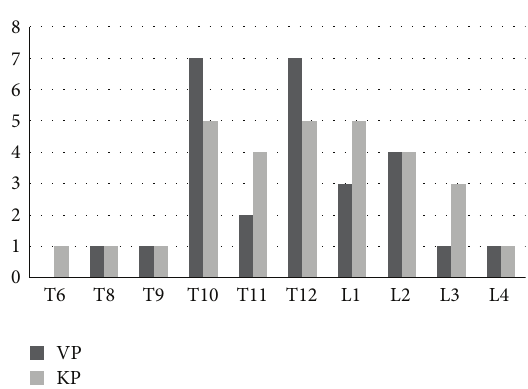
Figure 1: Incidence of vertebral fractures in the patients (both